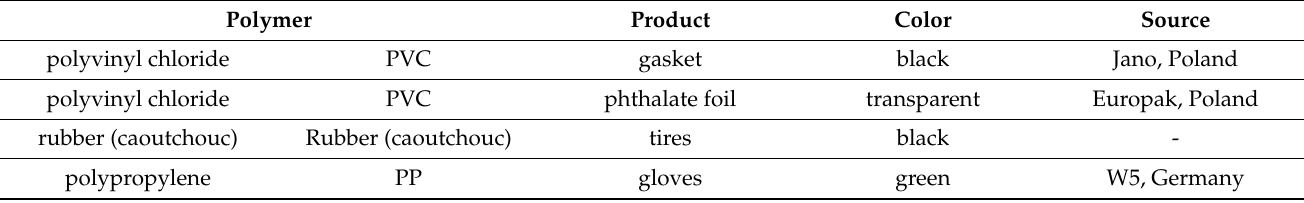
Table 2. Plastic products included in the